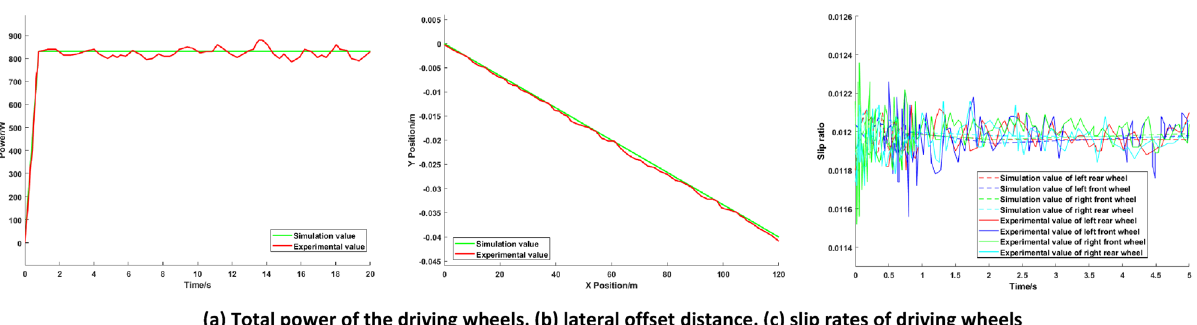
Figure 12. Experimental comparison diagrams of high load